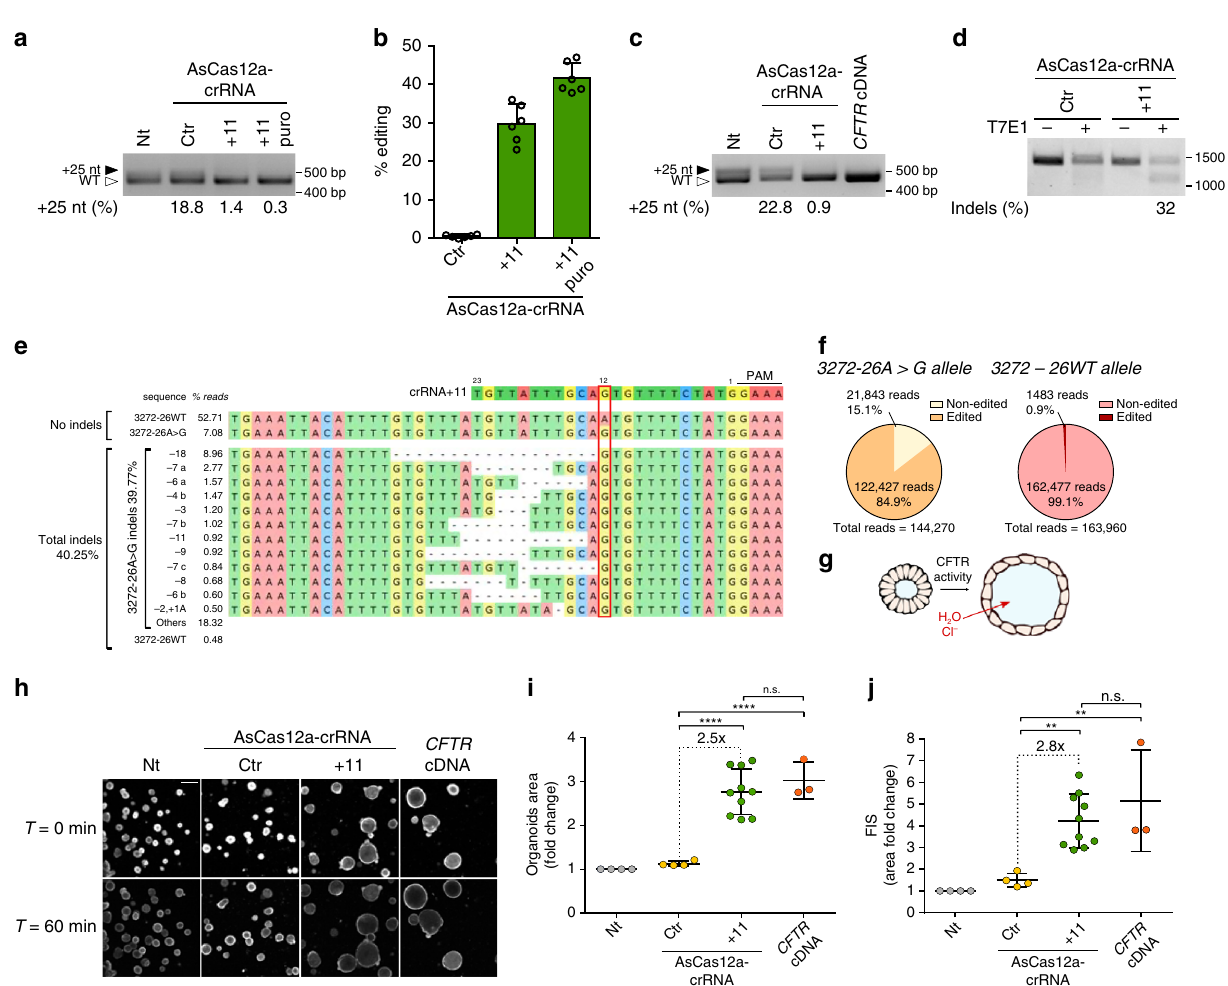
Fig. 3 AsCas12a-crRNA + 11 genome editing analysis in 3272-26A>G models. a Splicing pattern analysis by RT-PCR in 3272-26A>G primary airway cells following lentiviral transduction (15 days) of AsCas12a-crRNA control (Ctr) or speci fi c for the 3272-26A>G mutation ( + 11). Puromycin selection was performed for 72h in + 11 puro. Black-solid arrow indicates aberrant splicing, white-empty arrow indicates correct splicing. The percentages of aberrant splicing (25 nt insertion into mRNA) was measured by chromatogram decomposition analysis (Supplementary Fig. 5). b Percentages of indels generated in intron 20 by crRNA + 11 in cells treated as in a measured by TIDE analysis. Data are from n = 2 independent experiments. c Splicing pattern analysis by RT- PCR in 3272-26A>G intestinal organoids following lentiviral transduction (14 days) of AsCas12a-crRNA control (Ctr) or speci fi c for the 3272-26A>G mutation ( + 11) or with the CFTR cDNA. Black-solid arrow indicates aberrant splicing, white-empty arrow indicates correct splicing. The percentages of aberrant splicing were measured as in a (Supplementary Fig. 6a, b). d Editing ef fi ciency in 3272-26A>G organoids measured by T7E1 assay following lentiviral transduction as in c . e Deep sequencing analysis of the CFTR on-target locus after AsCas12a-crRNA + 11 transduction of the 3272-26A>G organoids (average from n = 2 independent experiments) (Supplementary Data 2). f Percentage of deep sequencing reads of the edited and non-edited 3272 – 26A>G or WT alleles from e . g Schematic representation of CFTR dependent swelling in primary intestinal organoids. h Representative confocal images of calcein green labeled 3272-26A>G organoids before ( T = 0 min) and after ( T = 60 min) forskolin-induced swelling (FIS) assay (5 µ M forskolin). Scale bar = 200 µ m. i Quanti fi cation of organoid area following lentiviral transduction of AsCas12a-crRNA Ctr, AsCas12a-crRNA + 11 or with CFTR cDNA as indicated. Each dot represents the average organoid area analyzed for a single well (number of organoids per well: 25 – 300) from n = 4 independent experiments. j Fold change in organoid area before ( T = 0 min) and after ( T = 60 min) the forskolin-induced swelling (FIS) assay, each dot represents the average increase in organoid area analyzed per well (number of organoids per well: 25 – 300) from n = 4 independent experiments. Data are means ± SD. Statistical analysis was performed using one-way ANOVA; ** P < 0.01, **** P < 0.0001, n.s. non-signi fi